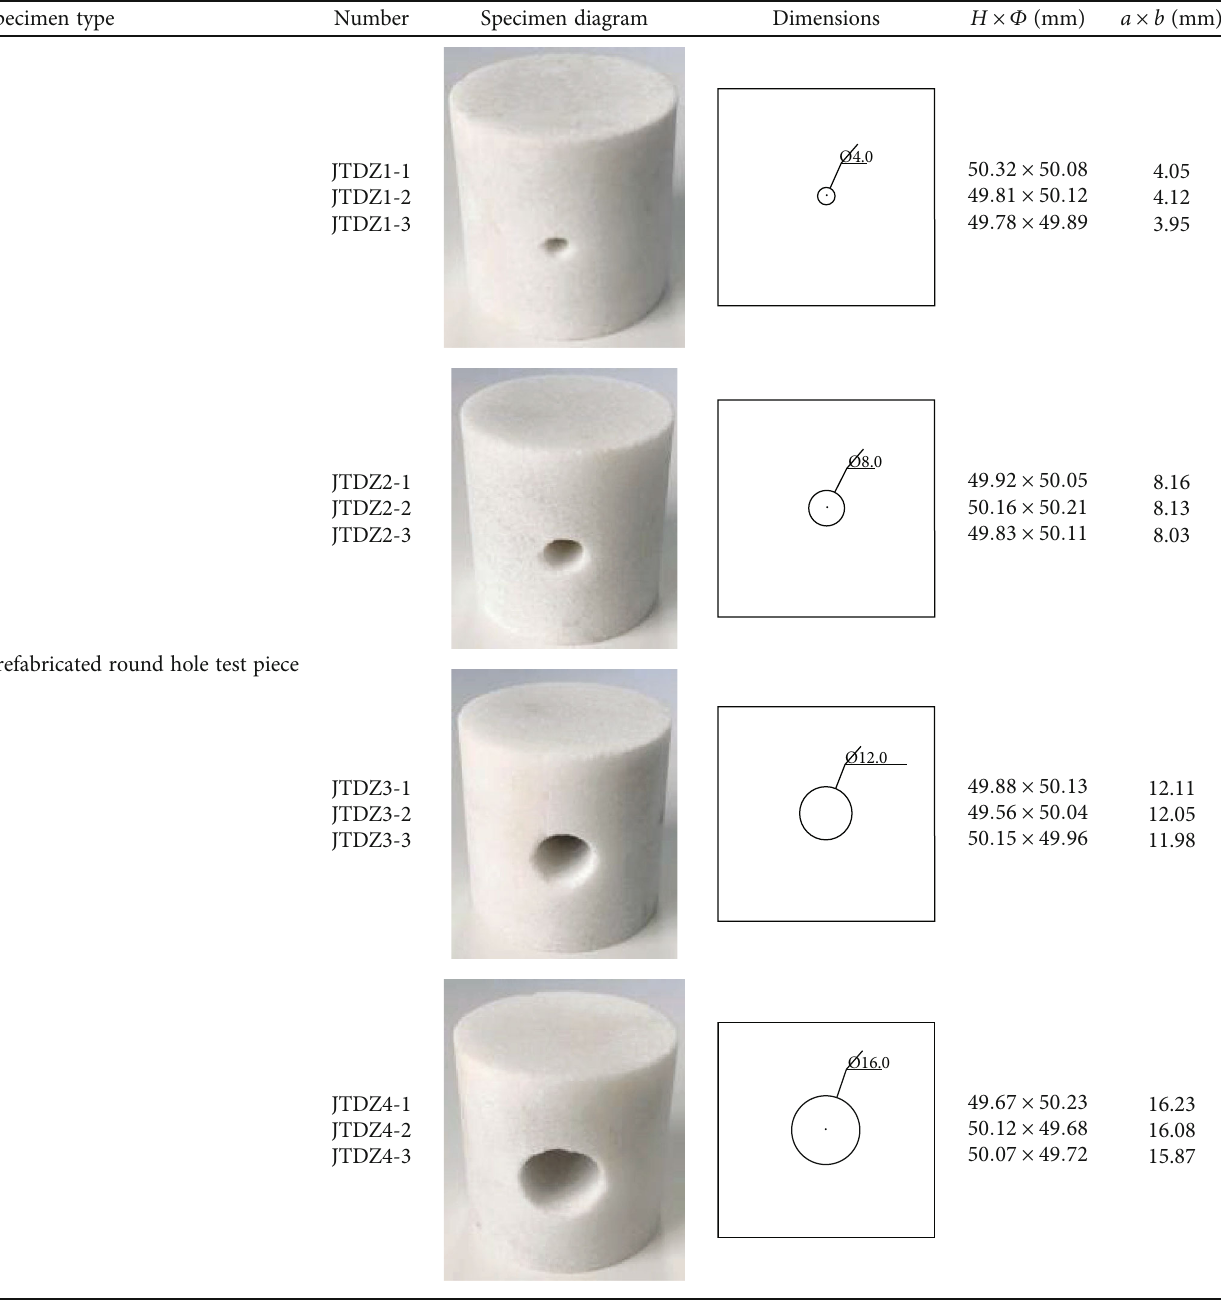
Table 1: Information of rock specimen in static uniaxial compression physical